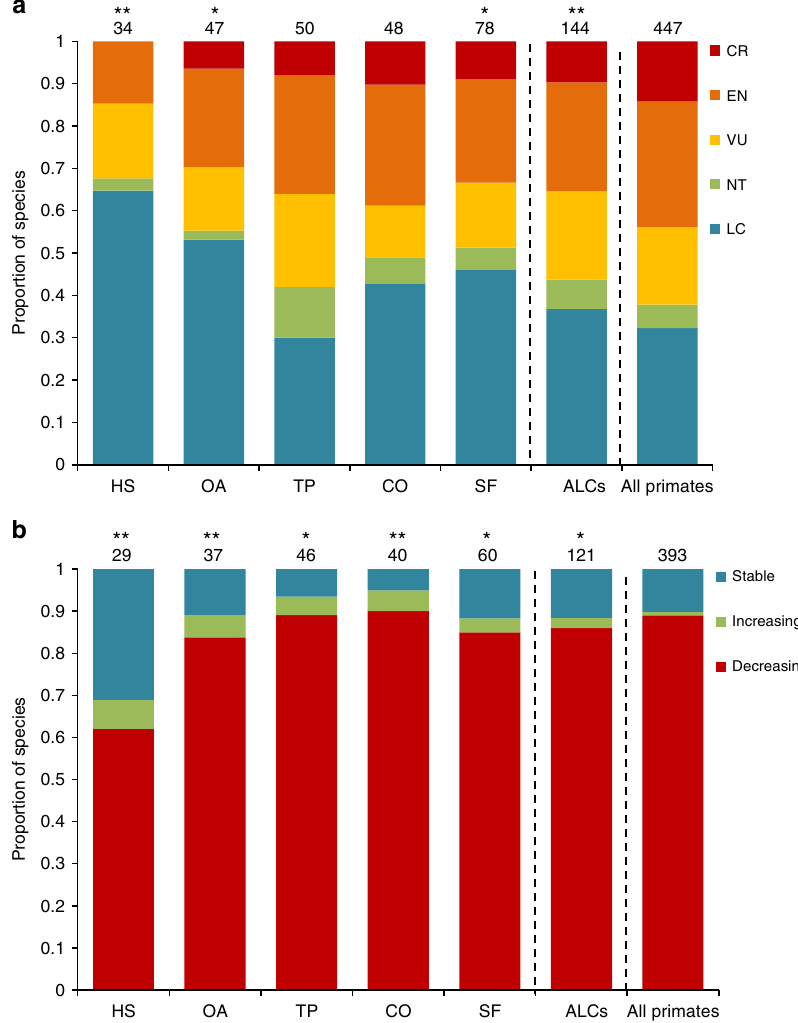
Fig. 3 Conservation status and population trends of primate species using anthropic land covers (ALCs) compared to all the world ’ s primates. The proportion (and total number above bars) of primate species within each IUCN threat category ( a ), and population trend ( b ), are shown. We tested for differences in frequencies with chi-square tests of goodness of fi t ( * P ≤ 0.05, ** P ≤ 0.01) between primates using ALCs and all the world ’ s primates, by separately assessing primate species that used different types of ALCs (HS human settlements, OA open areas, TP tree plantations, CO connectors, SF secondary forest). From higher to lower extinction risk, threat categories include: critically endangered (CR), endangered (EN), vulnerable (VU), near threatened (NT), and least concern (LC). We excluded species classi fi ed as data de fi cient and not evaluated in ( a ), and those whose population trends are unknown in ( b